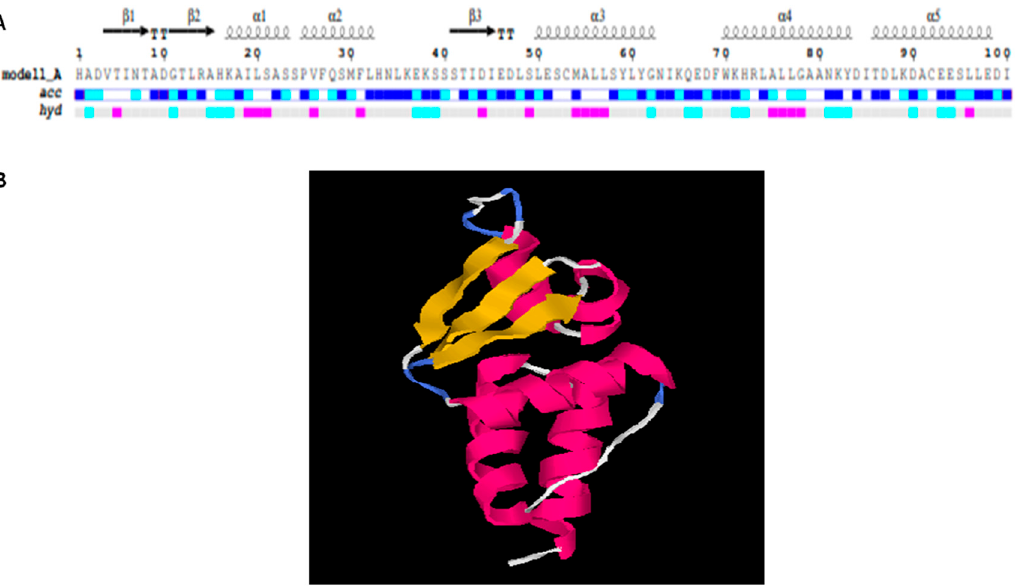
Figure 4. Structural analysis of BTB domain. ( A ) Secondary conformation of BTB domain represented in black-colored arrows ( β -sheets: β 1, β 2, β 3) and spiral forms ( α -helices: α 1, α 2, α 3, α 4 and α 5) along with sequence. ( B ) Detailed structural analysis indicates yellow-colored β -sheets and pink spiral forms are α -helices.